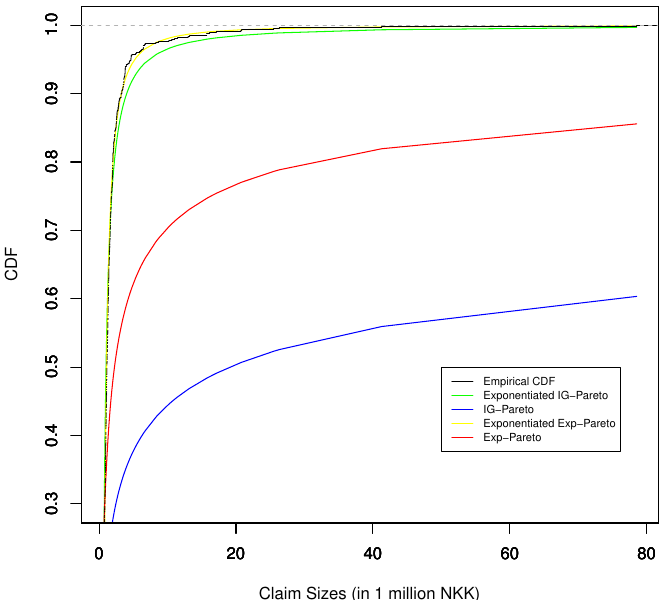
Figure 8. The empirical CDF of Norwegian fire insurance data and the fitted CDF of corresponding exponentiated IG-Pareto, IG-Pareto, exponentiated exp-Pareto, and exp-Pareto model